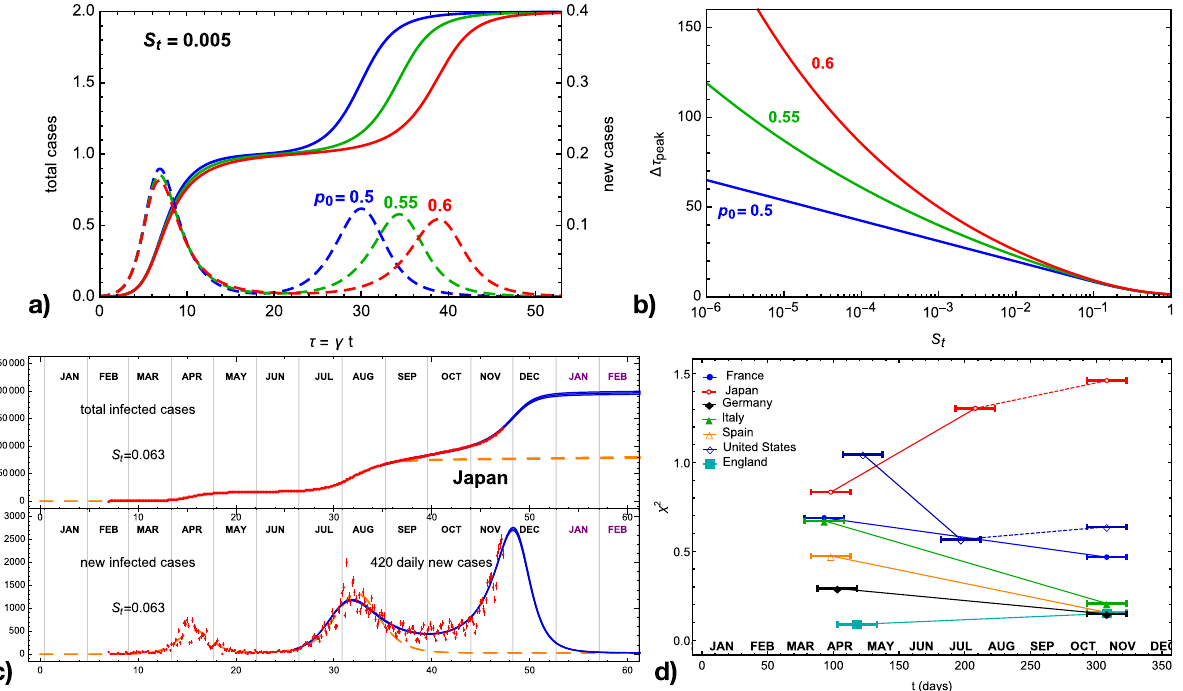
Figure 1. Illustration and validation of the CeRG multiwave model. The panel ( a ) shows sample solutions of the CeRG multiwave equation for w = 1 , with δ 1 = 0 , so that the epidemic episode is extinguished after two waves. The total number of cases, normalised to the first peak, is shown in solid, while the normalised new cases are shown in dashed. In the panel ( b ) we show the dependence of the delay between the two peaks of new infections, �τ peak measured in the local time, as a function of S t . The CeRG parameters are fixed to the following values, unless specified: p 0 = 0.5, p 1 = 0.65, ζ 1 = 0.5 . Panel ( c ) shows the CeRG model applied to the second and third wave in Japan (blue) as compared to the data (red) and the eRG fits of the two waves (orange). In panel ( d ) we show the value of the geographical uniformity indicator as defined in the text for a sample of countries, showing that the virus is more equally spread in the various regions during the second wave, in most three solutions (solid lines) together with the corresponding new cases (dashed lines), for three values of p 0 . We can clearly see the two-wave structure emerging in the solution, the fact that the second peak tends to be flatter than the first (for ζ 1 = 1 / 2 ). Furthermore, larger values of the exponent p 0 tend to delay the second peak and flatten it. An important factor in controlling the arrival of a future wave is the number of new cases during the intermediate strolling phase, which we encode in the parameter